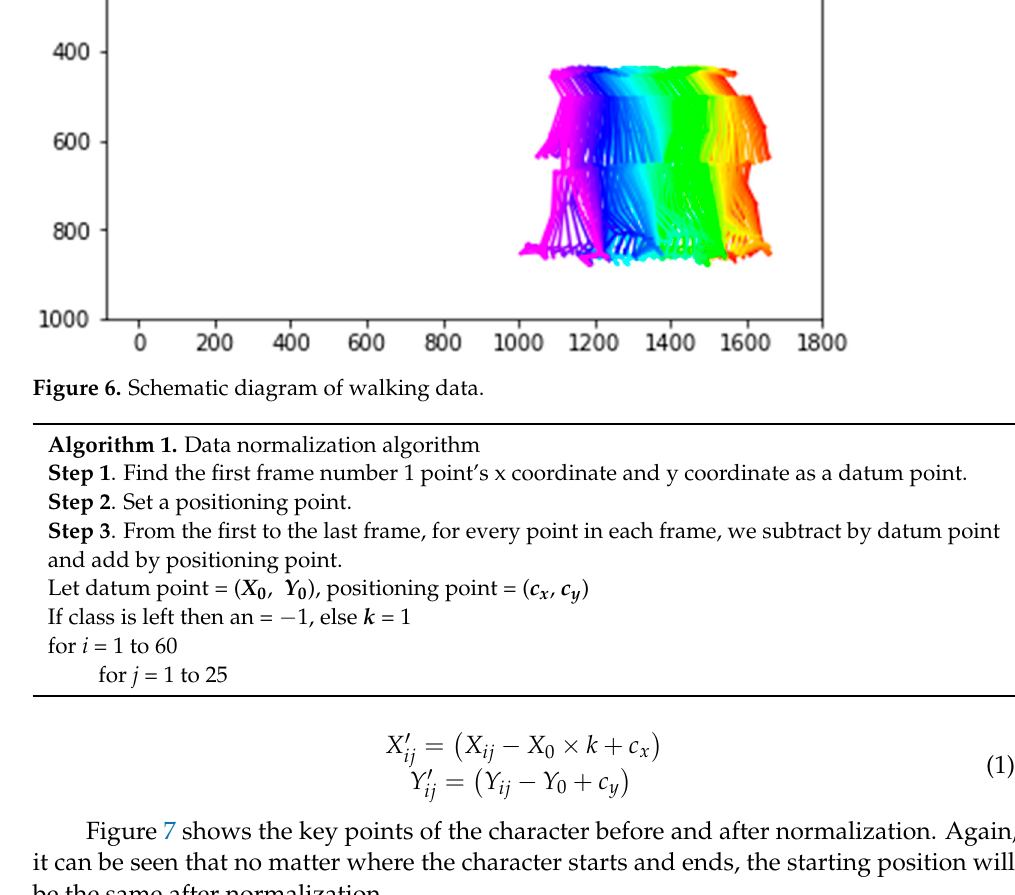
Algorithm 1. Data normalization algorithm